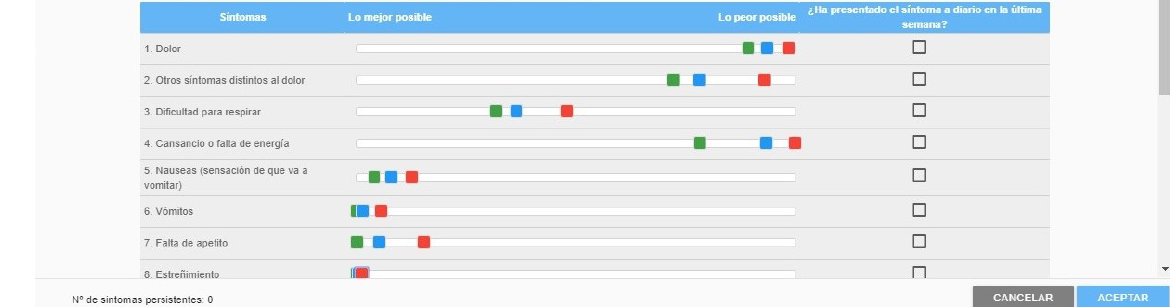
Figure 3. Example of answers collected from an electronic form via the web using a fuzzy rating scale that generates triangular FNs.